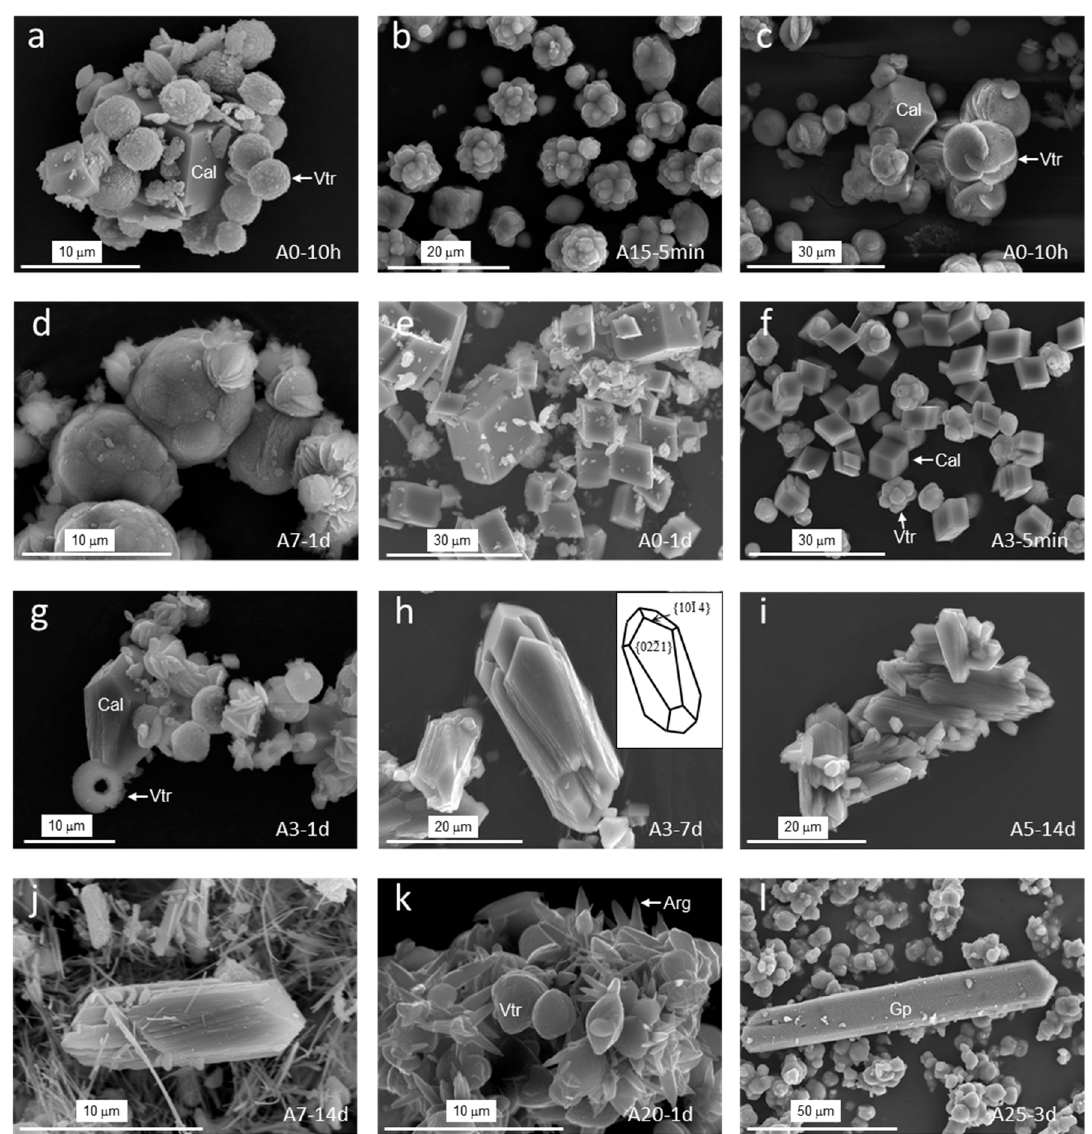
Figure 5. SEM images of the precipitates recovered from solutions with different (SO 42 − )/(CO 32 − ) ratios after various elapsed times ranging from 5 min to 14 days. Vaterite appears as cauliflower-like aggregates ( a , b ) or lens-shaped crystallites ( c , d ). When there is no sulphate in the solution, the calcite crystals are bounded by flat {10–14} rhombohedron faces ( a , c , e ). In solutions with a moderate concentration of sulphate, the calcite crystal habit undergoes an evolution characterized by a progressive increase in elongation along [001] ( f – j ) and by the emergence of the {02–21} form (see inset in h ). Aragonite appears as crystals with the so-called “morning-star” morphologies ( k ). Gypsum crystals exhibit tabular habits with the {010} form as the main face ( l